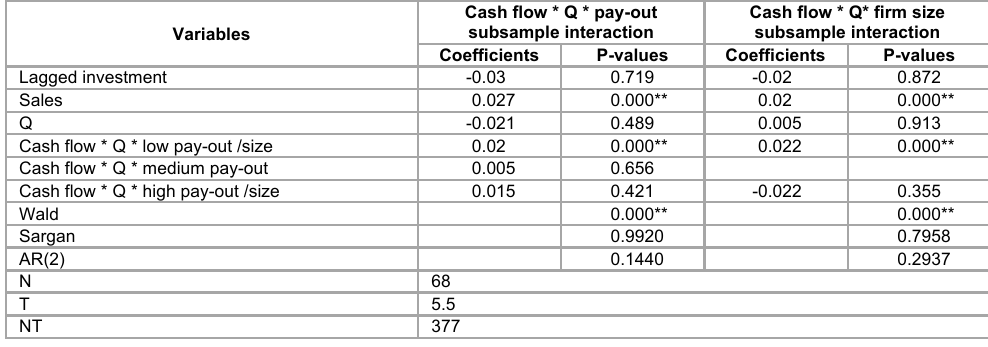
Cash flow interaction with Q and subsamples of pay-out and firm size